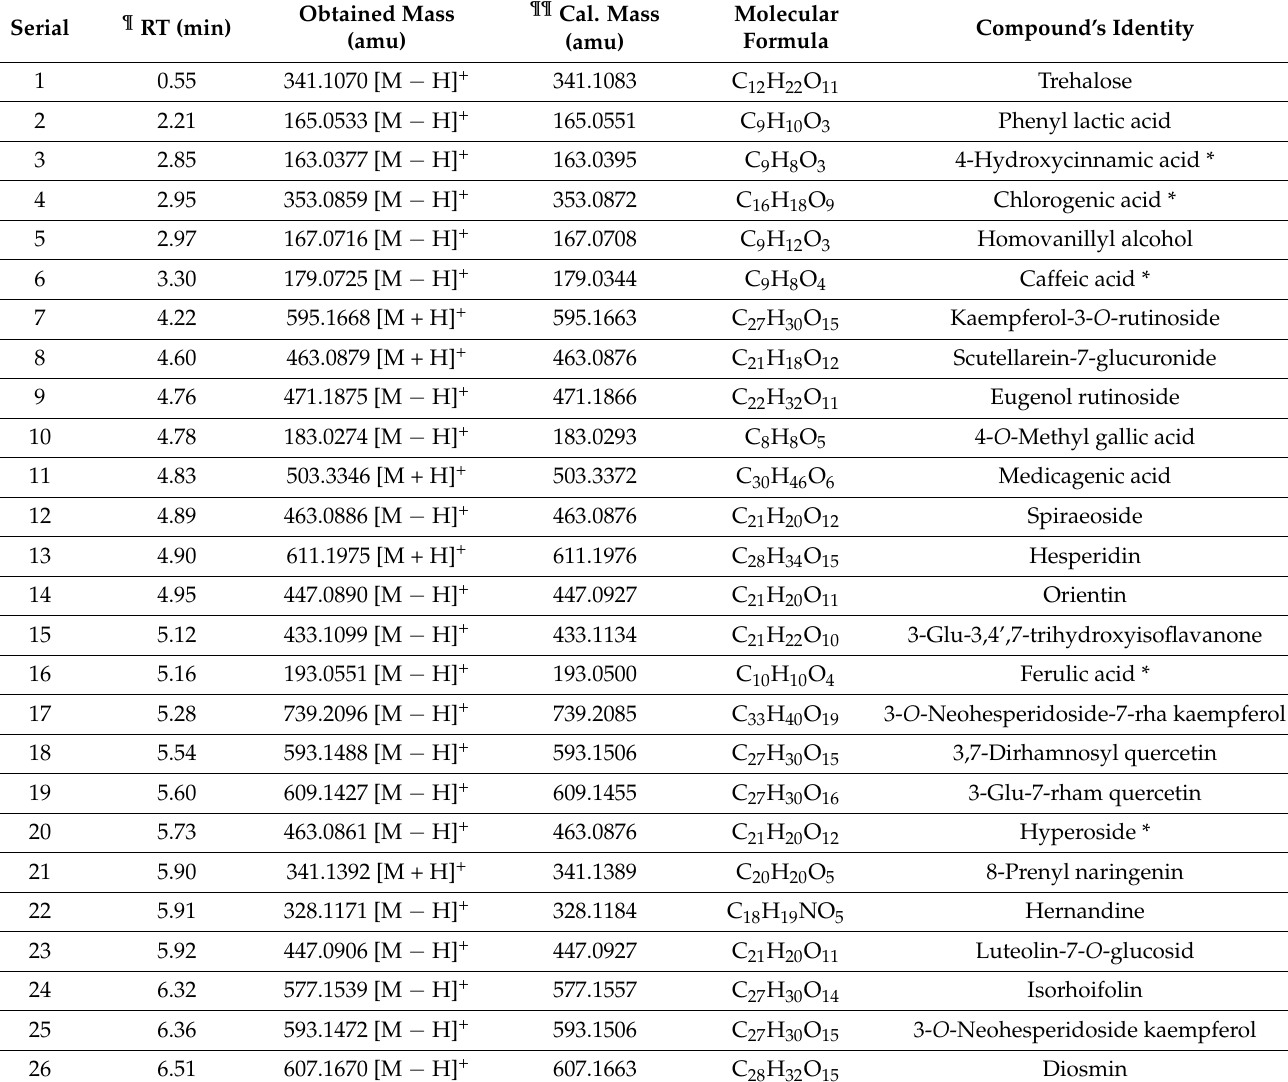
Table 1. LC-MS analysis of the 95%aqueous-ethanolic extract of the S.